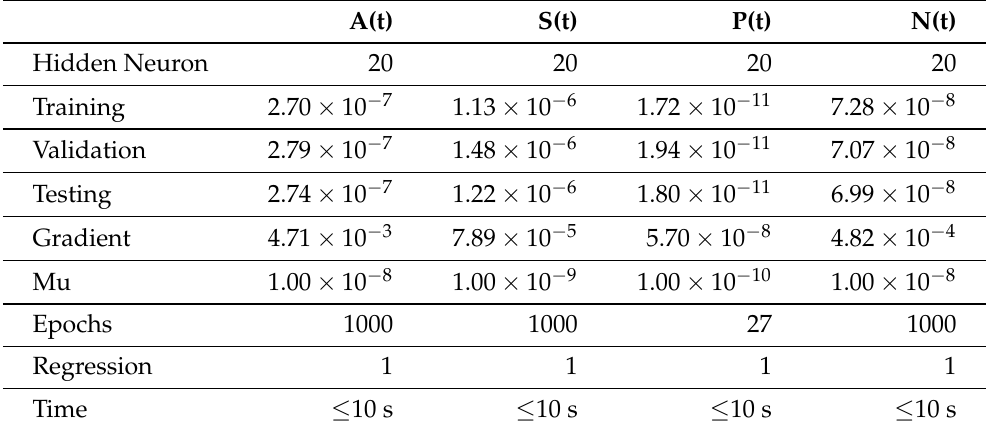
Table 4. Gradient, MSE, number of iterations, mu, and time spent by the computing system to get solutions for Case 2.